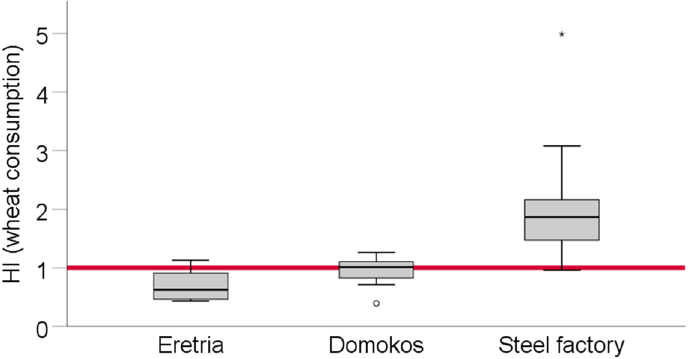
Figure 6. Hazard index for wheat grain product consumption. Circles and asterisks denote outlier values.